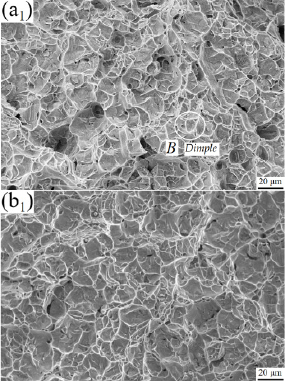
Figure 12. Micromorphology of tensile fracture after BASC and BASCA treatment BASC heat treatment: ( a 1 – a 4 ); BASCA heat treatment: ( b 1 – b 4 ).